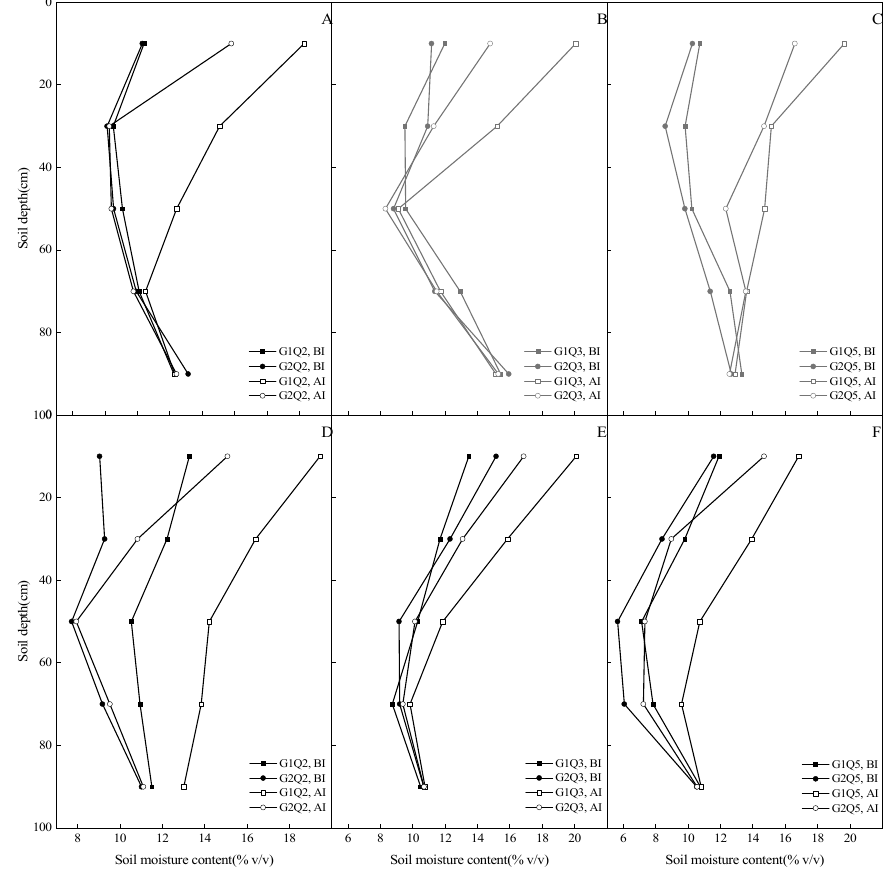
Figure 3. Dynamics of soil moisture content (SMC, cm 3 cm − 3 ) in 0–100 cm soil layers before irrigation (BI) and after irrigation (AI) events at ( A – C ) booting stage and ( D – F ) filling stage of winter wheat.